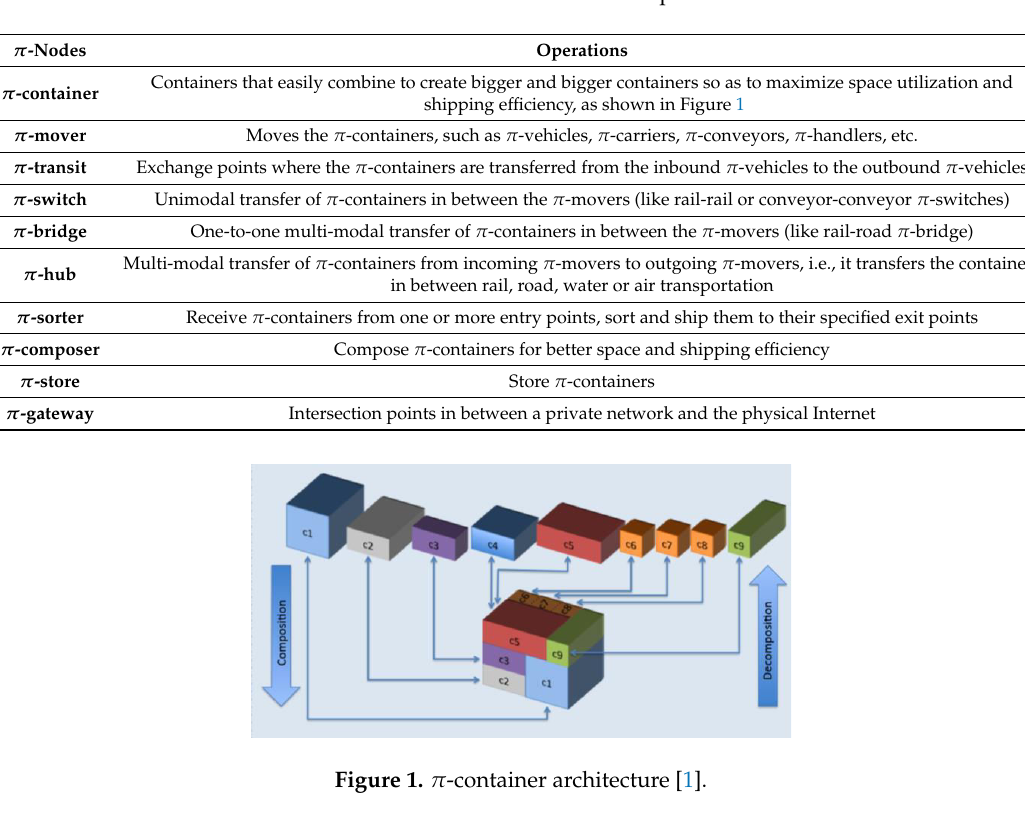
Table 1. Different π -nodes and their operations.